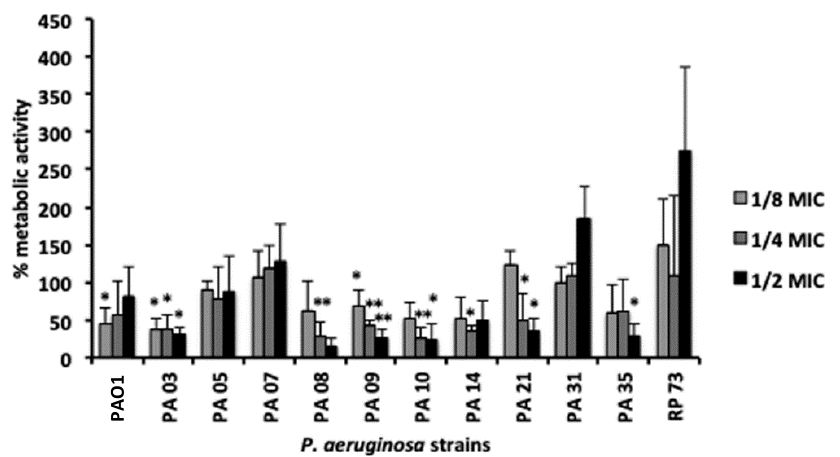
Figure 2. D -BMAP18 inhibition of biofilm formation against CF isolates of P. aeruginosa strains evaluated by MTT assay. Percentages of metabolic activity of biofilm compared with the untreated controls (100%) are shown. The results are the average of three independent experiments performed as internal triplicate ( n = 6). * = p < 0.05, ** = p < 0.01. Student t test, treated vs untreated cells.